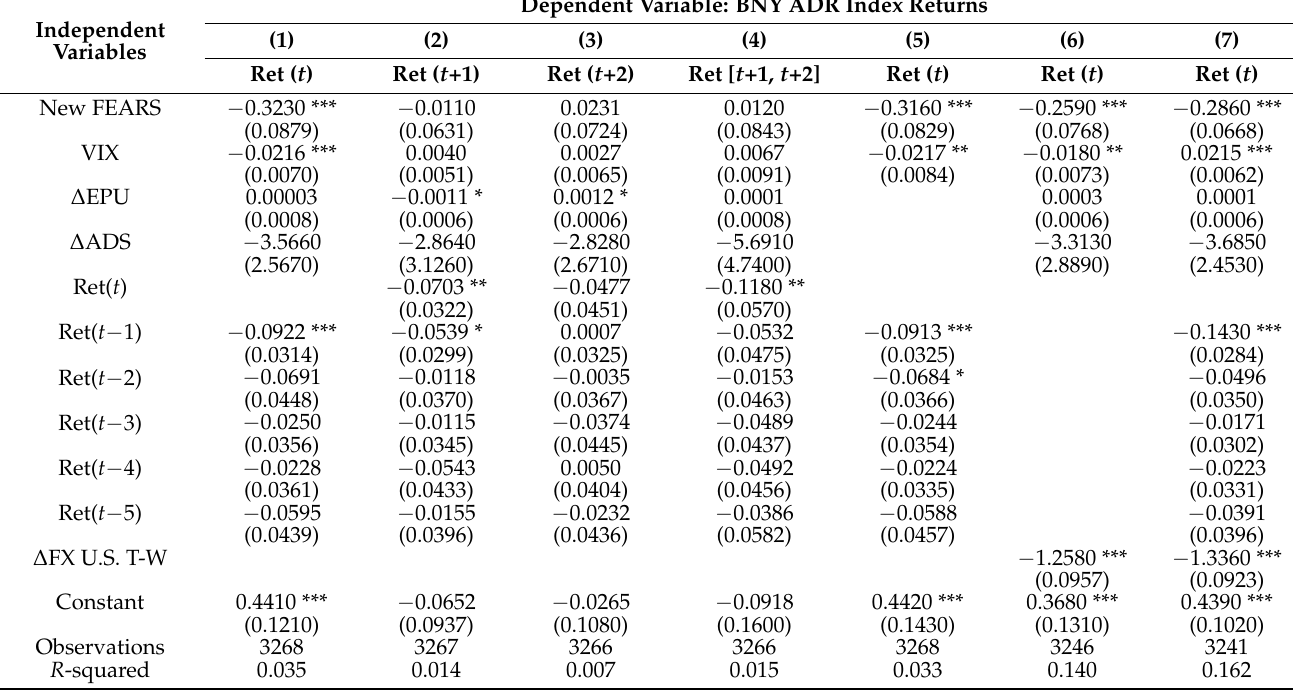
Table 3. New FEARS and ADR index